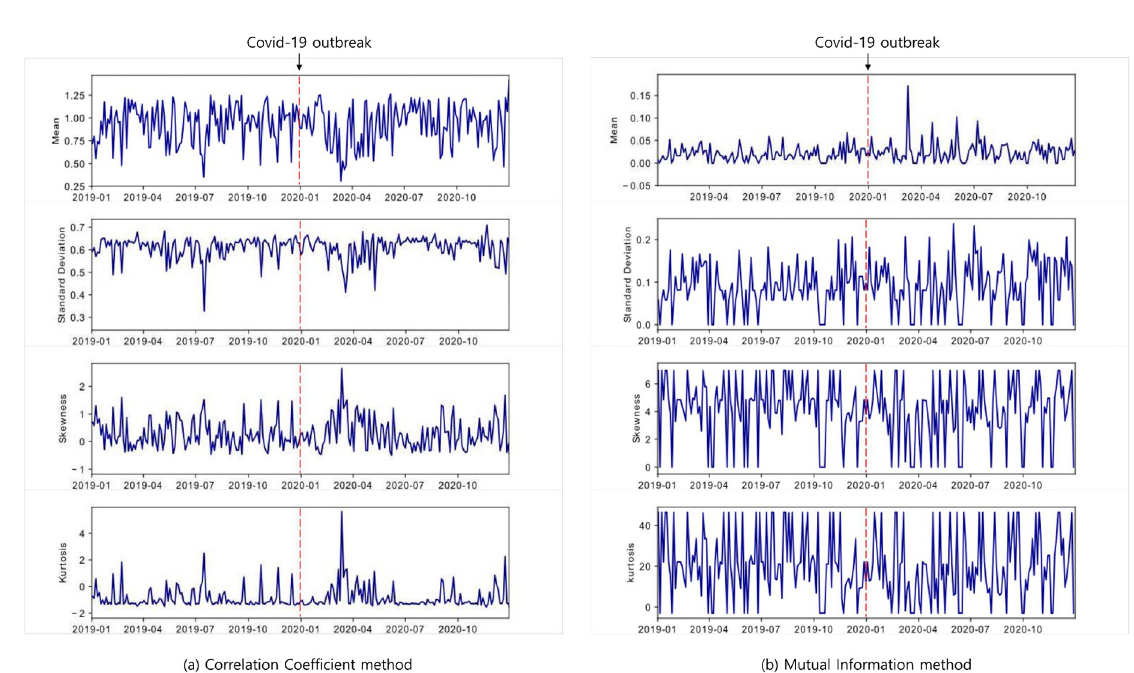
Fig 5. The mean, standard deviation, skewness, and kurtosis of distance matrix of correlation coefficient and mutual information methods at each time step.